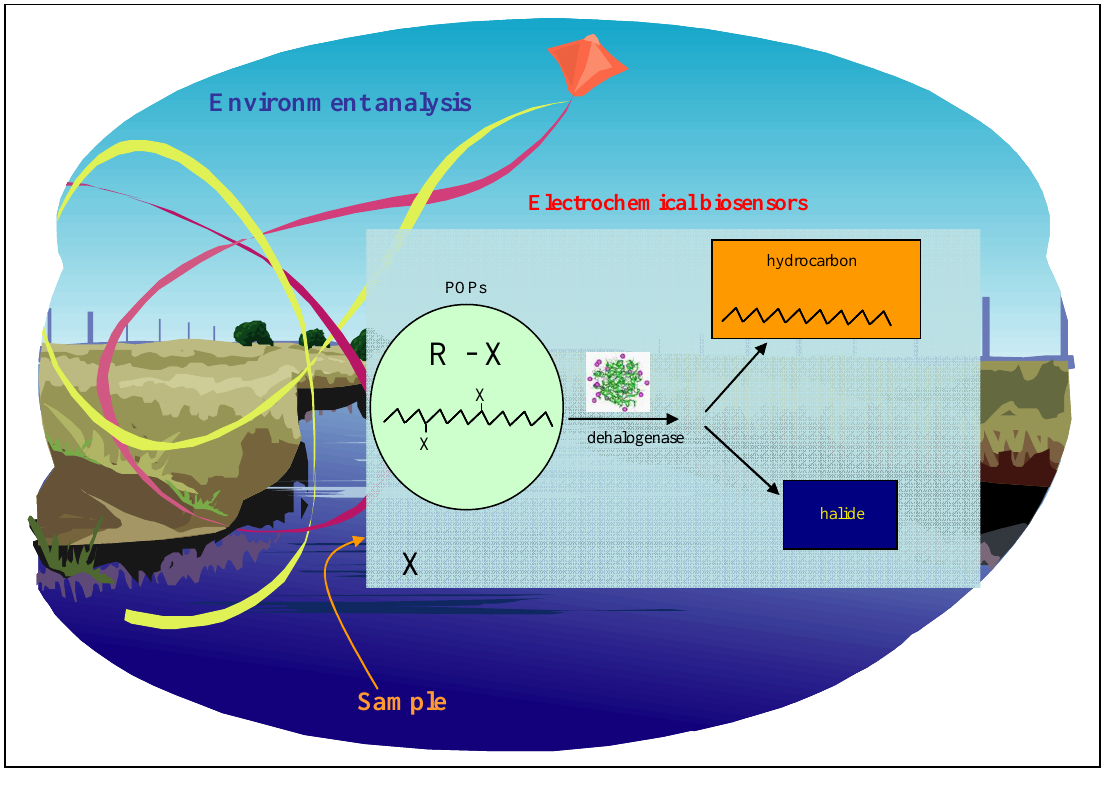
Figure 9. Suggestion of enzyme biosensor for analysis of POPs. Pollutant is introduced on the biosensor, where enzymatic cleavage of the pollutant takes place. Hydrocarbon and chloride are released during reaction. Released chloride is